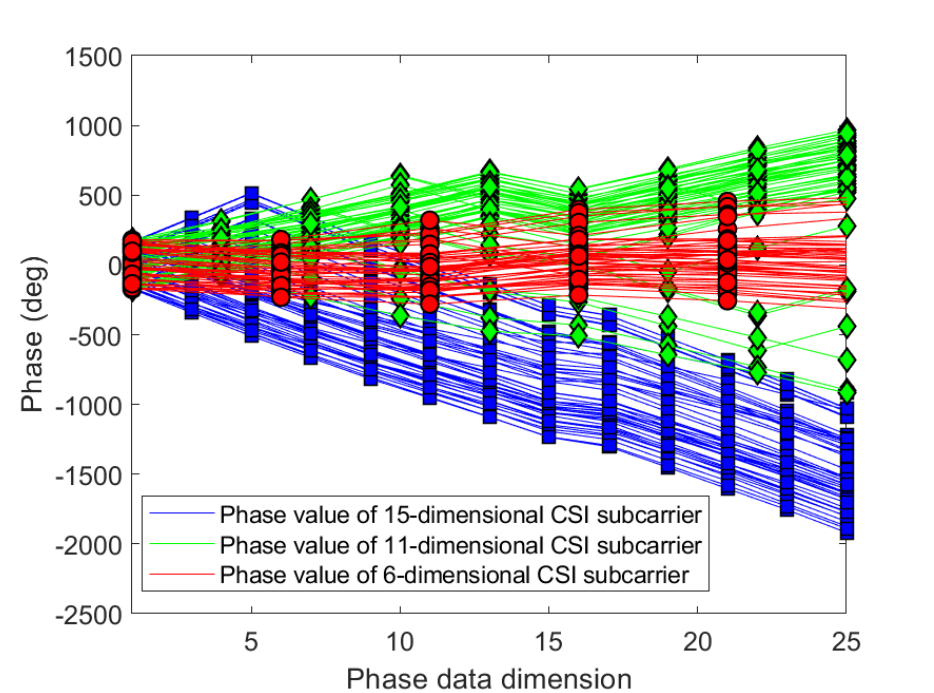
Figure 16. Compare the phases change trends with different dimensions on antenna a at reference point (0,1) of AP1 in the corridor of IT1 building.